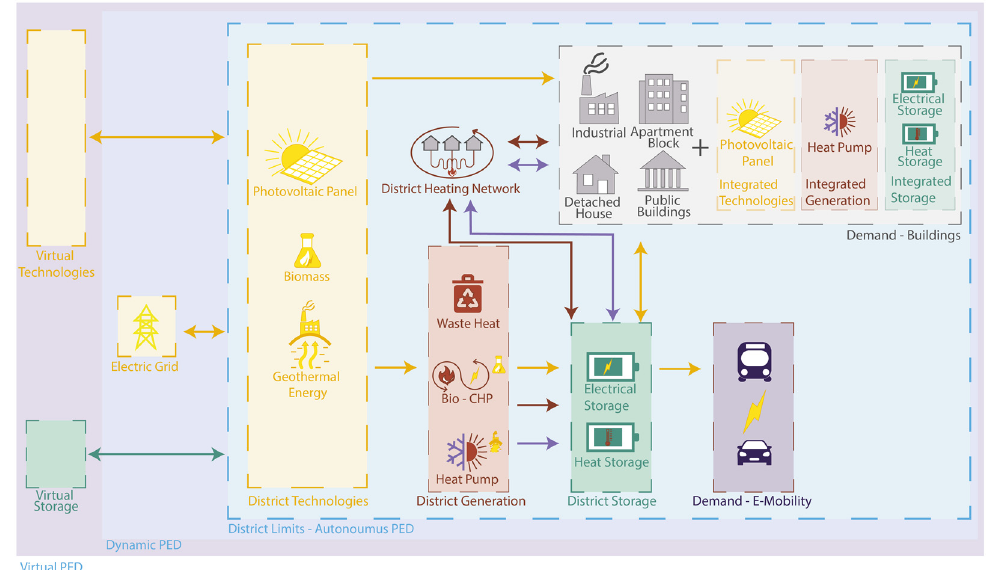
Figure 10. Summary diagrams of the most frequently used technological choices in continental climate Dfb/Dfc.